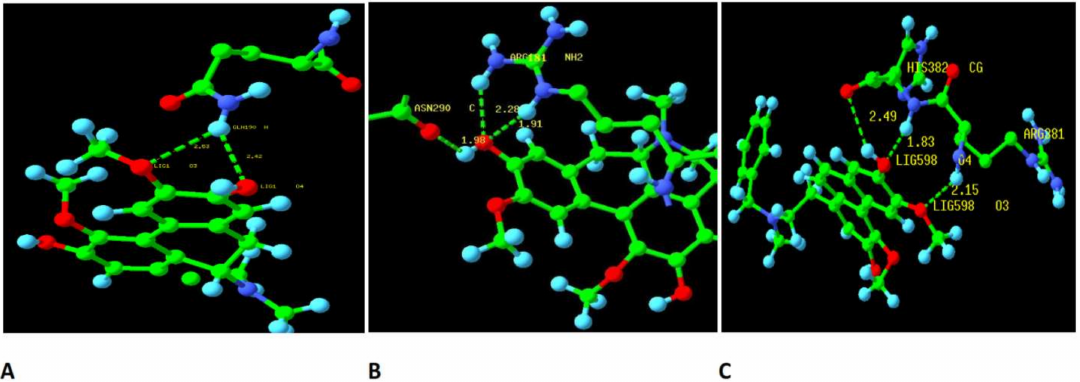
Figure 5. The hydrogen bond plot after 10 ns molecular dynamics simulations between ( A ) boldine (initial structure obtained after focused docking screen) in complex with TERT; ( B ) boldine (initial structure obtained after blind docking screen) in complex with TERT; ( C ) BSB (initial structure obtained after focused docking screen) in complex with TERT. The carbon, nitrogen, oxygen and hydrogen atoms were shown in green, blue, red and light blue colors,